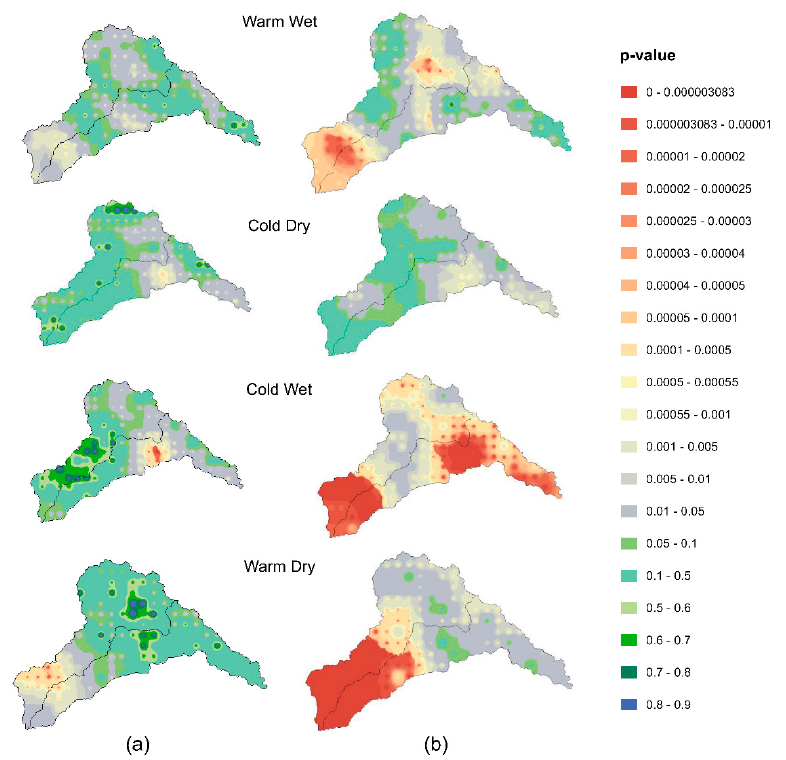
Figure 10. The p -values for the K-S Test comparing the APHRODITE data with selected GCMs data and conventional composite mean data of 21 GCMs for warm-wet, cold-dry, cold-wet and warm-dry season ( a ) Using Selected GCMs ( b ) Simple mean Multimodel Ensemble. The green color bands are presenting the zones where the null hypothesis of “similar distribution” is not rejected.